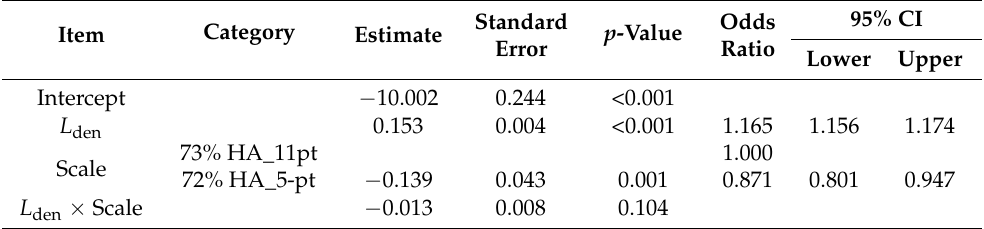
Table 7. Multiple logistic regression analysis of aircraft noise surveys from 2008 to 2018 in Vietnam (AUC = 0.724).